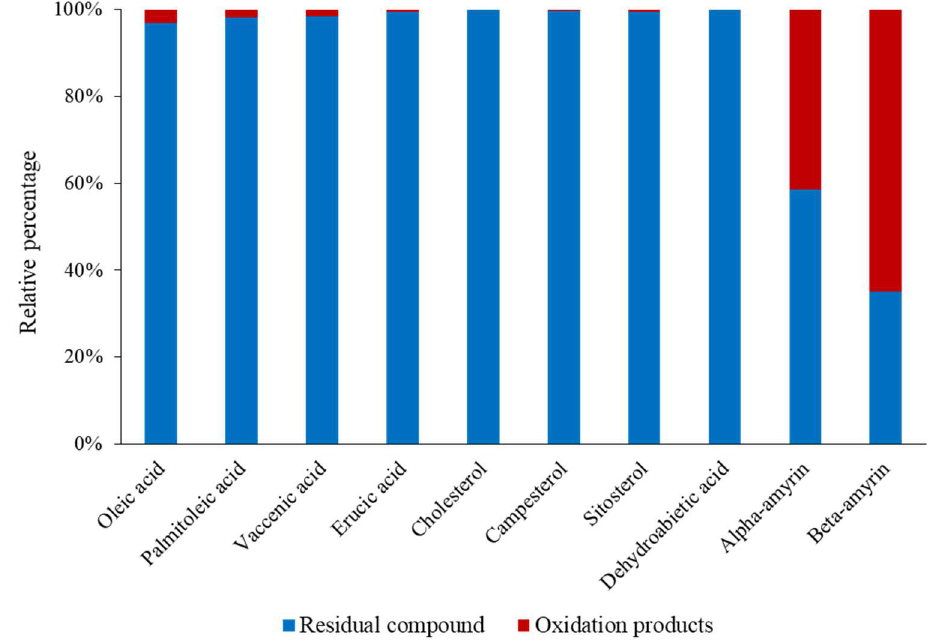
Figure 1. Oxidation state of the main lipids detected in Negev loess deposits.